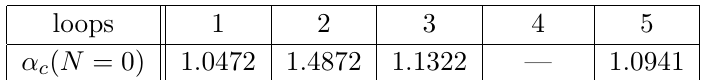
computed from (4.11) up to 5 loops (the 4